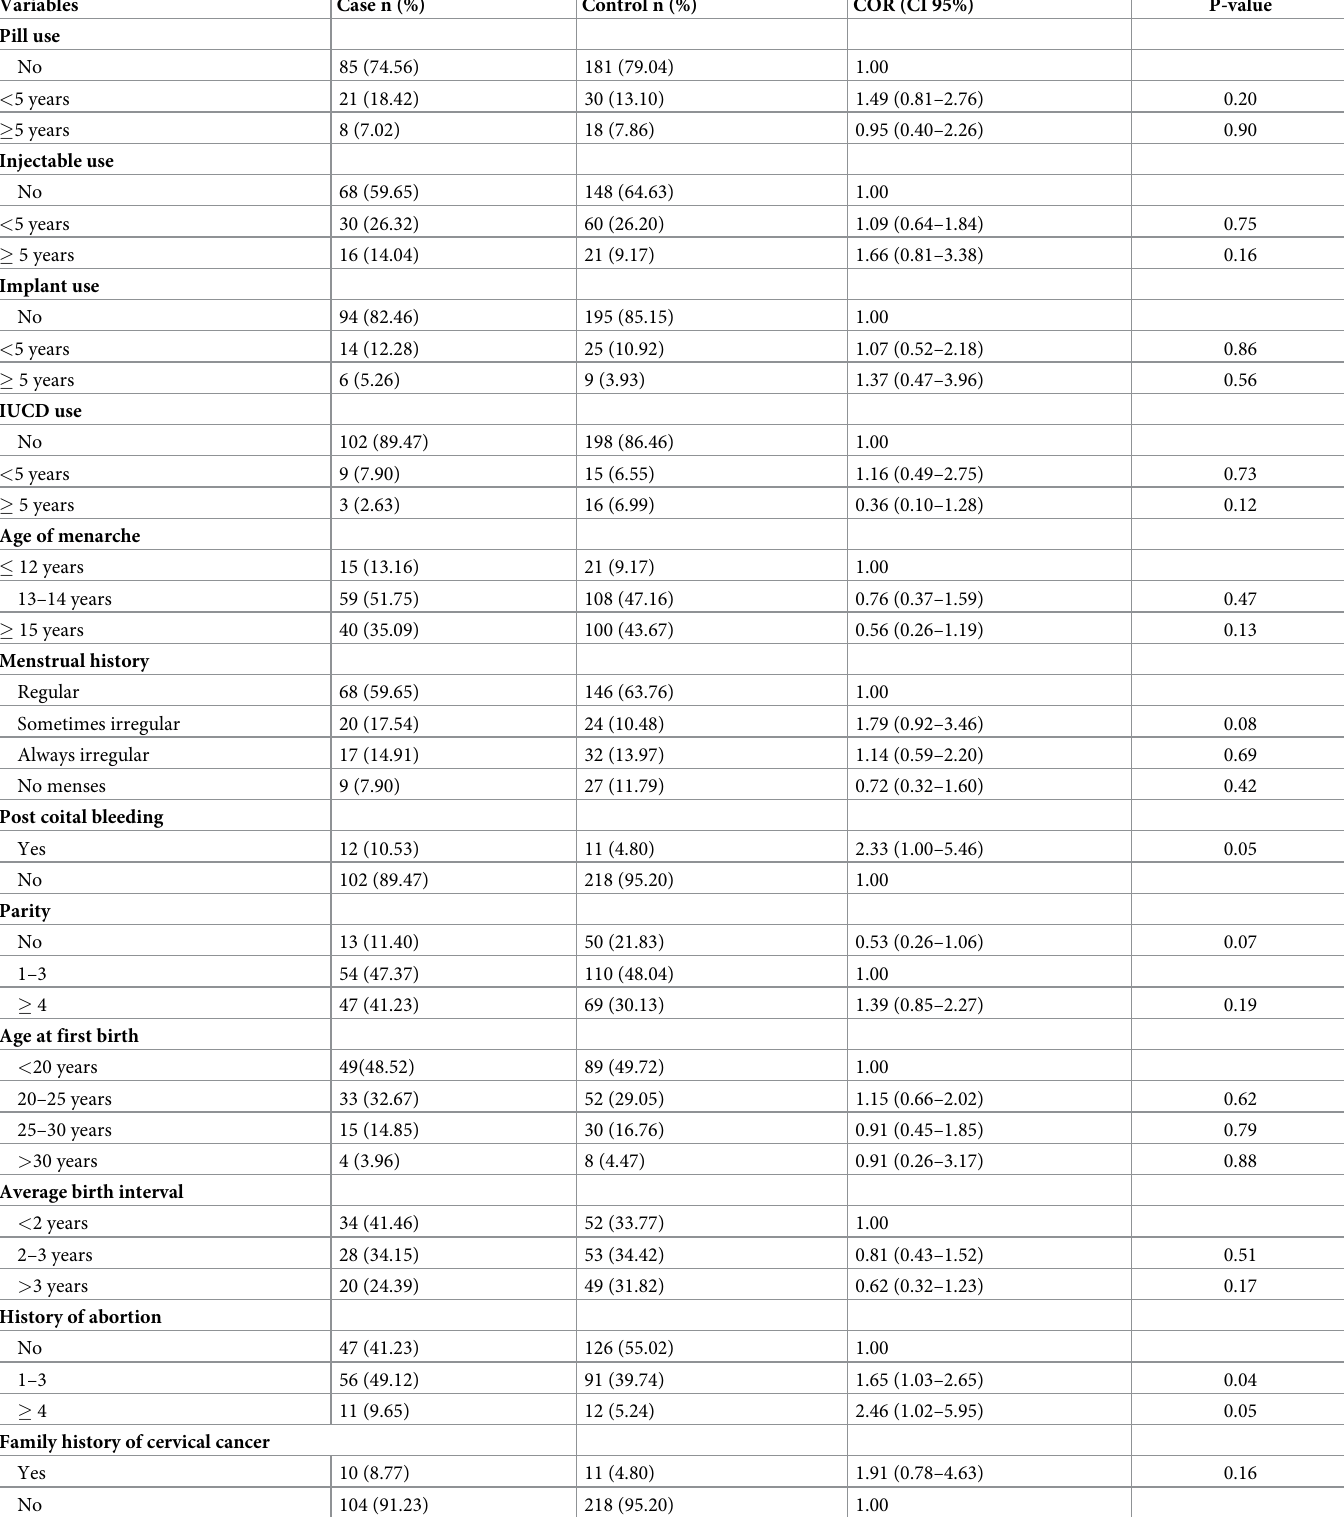
Table 2. Reproductive health related characteristics of screened women in Addis Ababa, Ethiopia,